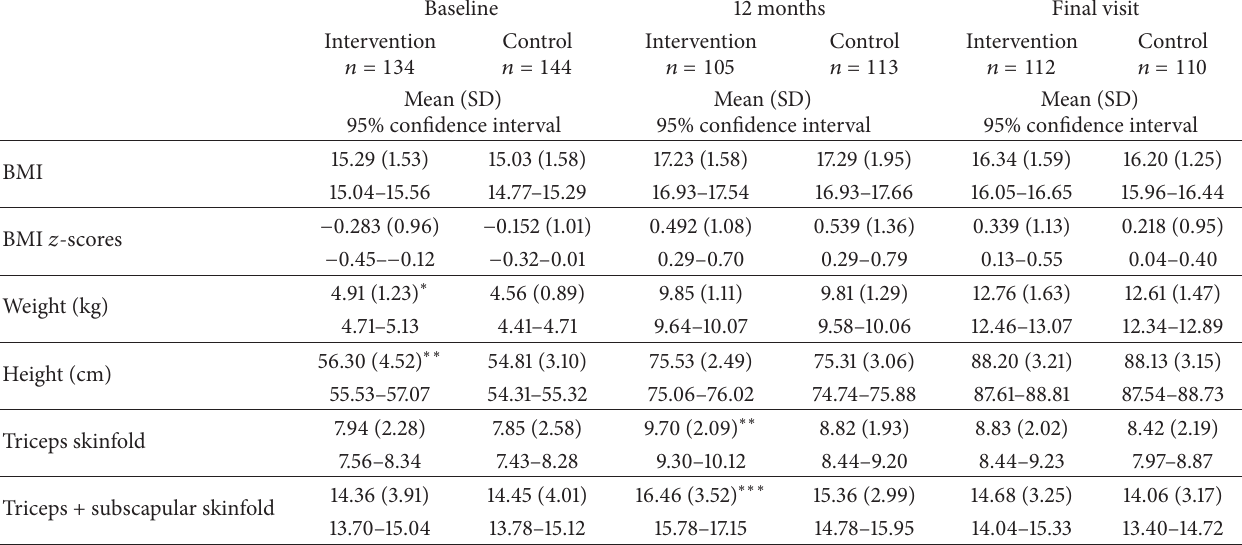
Table 1: Anthropometric measurements of babies at baseline, 12 months, and final visit a